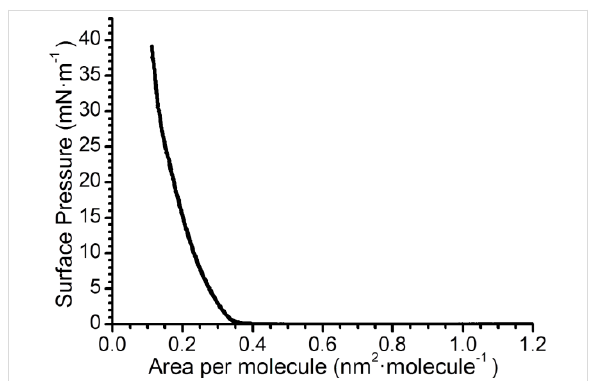
Figure 2: Surface pressure vs area per molecule isotherm of 1 at 20 °C.